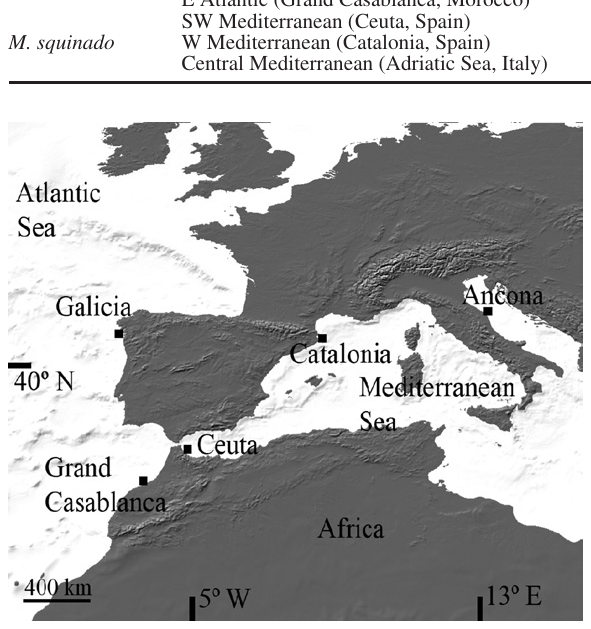
Fig. 1. – Map of sampling locations for isotope studies of Maja brachydactyla and Maja quinado